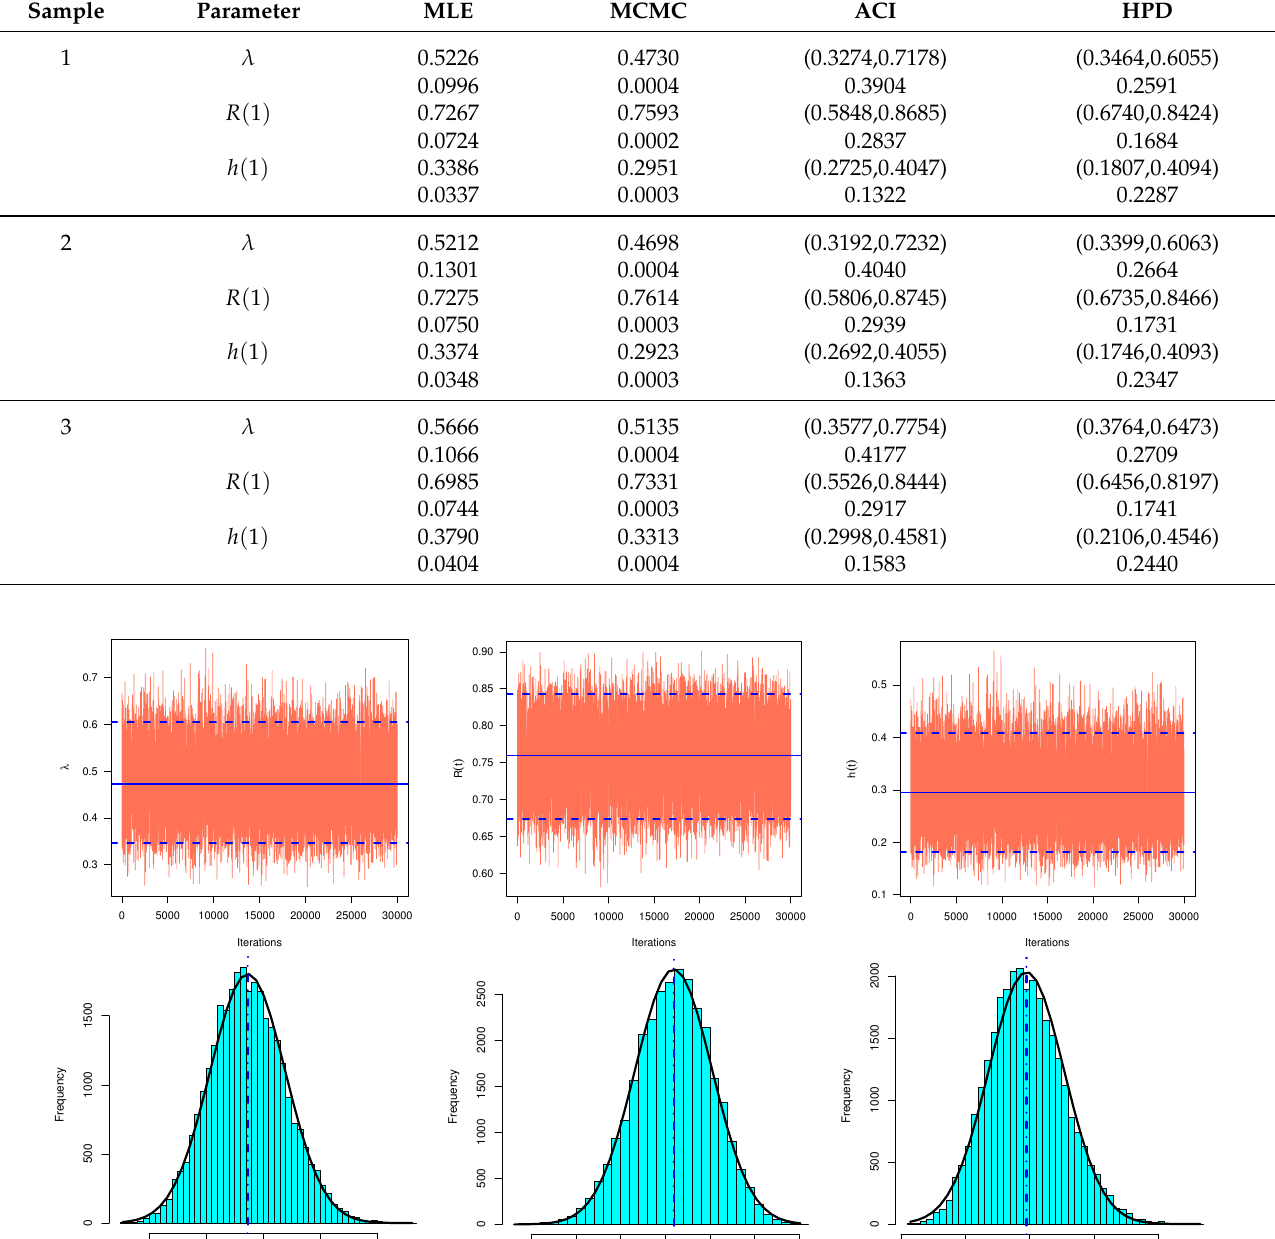
Table 6. The point and interval estimates of λ , R ( t ) , and h ( t ) from vinyl chloride data.